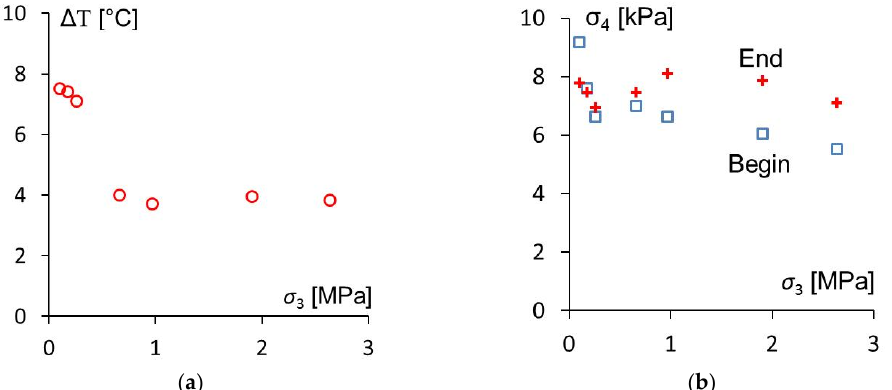
Figure 15. Temperature change Δ T ( a ) und shear stress σ 4 ( b ) near the beginning and end of the vibrations as a function of the pressure σ 3 compressing the samples.